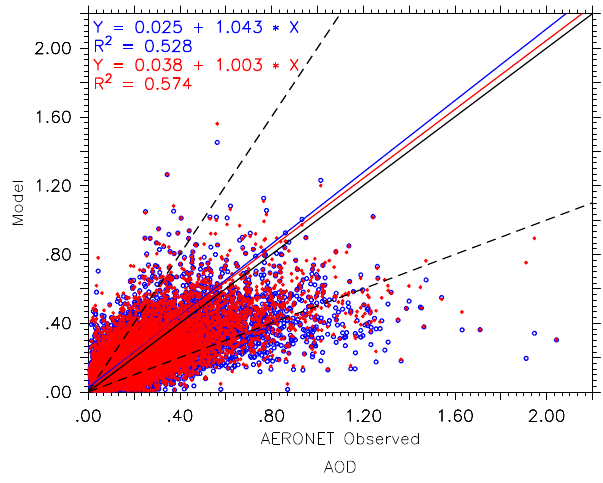
Figure 1. Scatter plot of observed (AERONET) and simulated daily AOD. The model is sampled in the same temporal/spatial location of the observations. The colored lines represent the linear fit, with the coefficient listed in the figure: blue – model results from simulation FIXEMI; red – model results from simulation